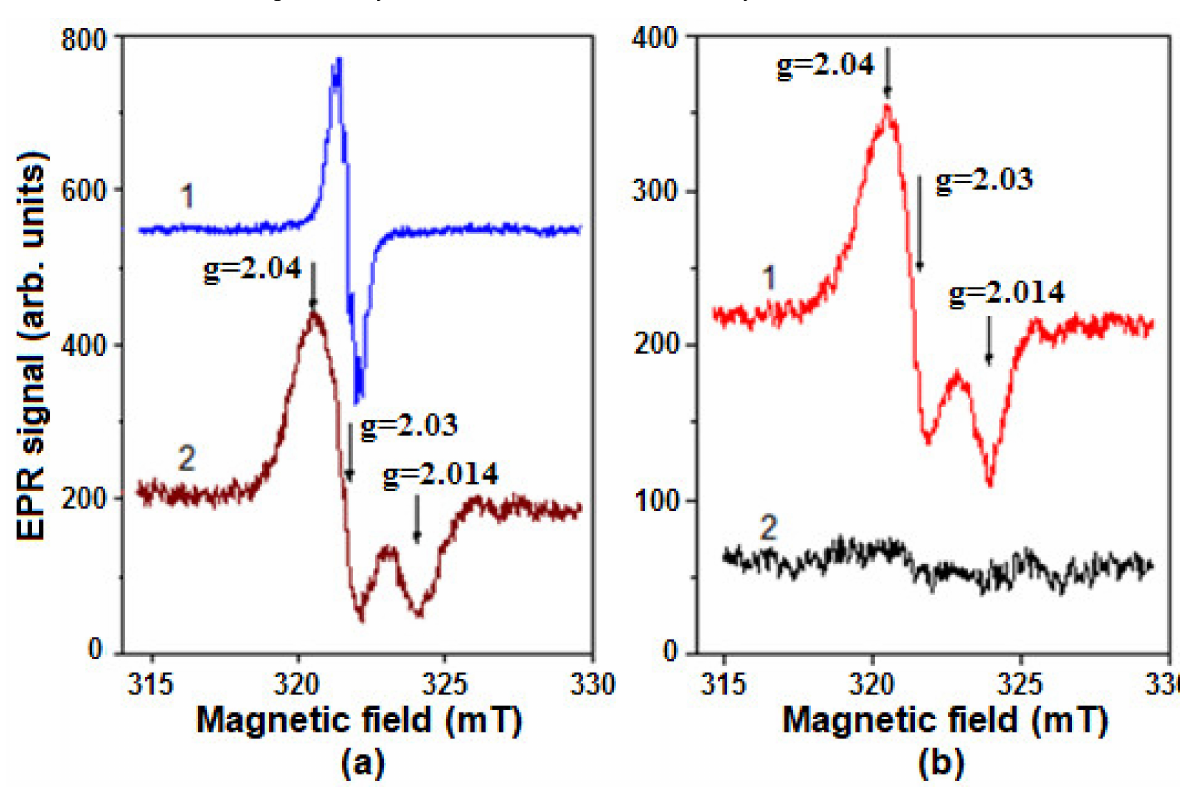
Figure 8. Electron paramagnetic resonance (EPR) spectra of DNICs bound with human methemoglobin (metHb) and soybean metLb. ( a ): 1—the spectrum of DNICs with phosphate ligands used to produce protein DNIC; 2—spectrum of Hb-bound DNICs (Hb-DNICs). ( b ): 1—spectrum of Lb-bound DNICs (Lb-DNIC); 2—the same as (1) + 1 mM t -BOOH. Spectra recorded at room